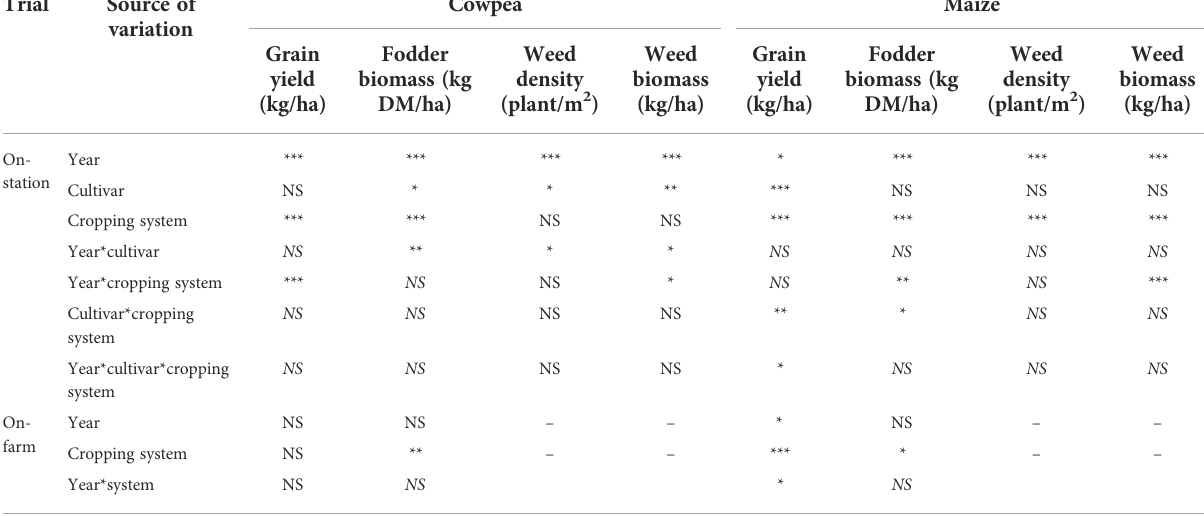
TABLE 4 Statistical analyses of grain yield, fodder biomass, weed density, and weed biomass for cowpea and